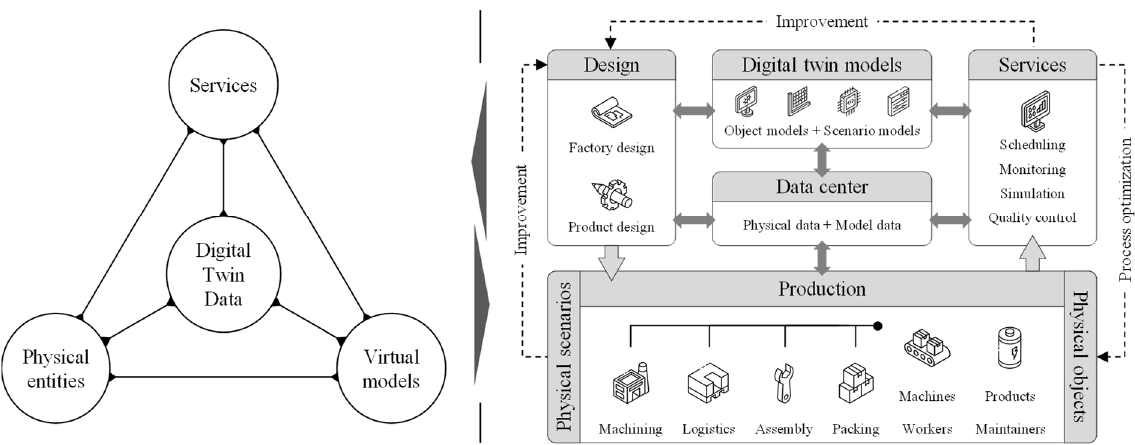
Figure 1. Five-dimension model (left) and composition and application of digital twins (right). Adapted from [9].